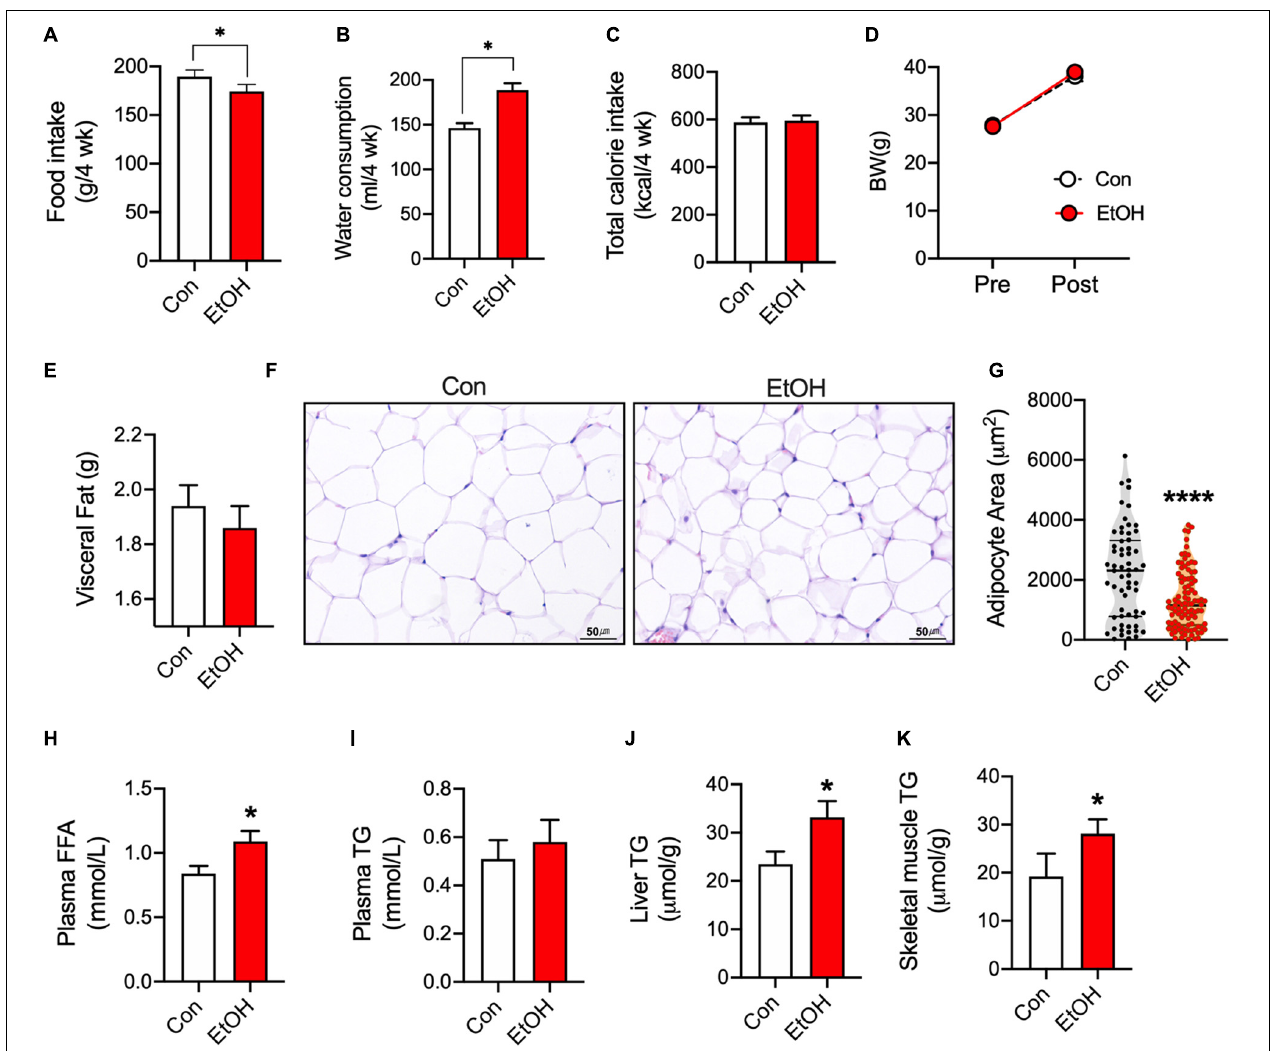
FIGURE 1 | Chronic alcohol consumption released fatty acids from adipose tissue and increased triglyceride accumulation in mouse skeletal muscle. (A) Food intake ( n = 6 mice), (B) Water consumption ( n = 6 mice), and (C) Total calorie intake ( n = 6). Values are means ± SE. * P < 0.05. Significance was determined using the student’s t -test. (D) 5% EtOH consumption did not affect body weights ( n = 6 animal/group). (E) Visceral fat weights ( n = 6 tissue/group). (F) Sections of epididymal white adipose tissue from mice after treatment with water or 5% EtOH. (G) Adipocyte area was quantified from section of adipose tissue. Values are means ± SE. **** P < 0.0001. Significance was determined using the student’s t -test. (H) EtOH consumption increased plasma free fatty acid levels (FFA) ( n = 6 plasma/group). Values are means ± SE. * P < 0.05. Significance was determined using the student’s t -test. (I) Plasma triglyceride (TG) level ( n = 6 plasma samples/group). (J , K) EtOH consumption increased liver and skeletal muscle TG levels ( n = 6 tissue samples/group). Values are means ± SE. * P < 0.05 versus non-treated controls. Significance was determined using student’s t -test. (G) H&E staining was used to determine adipocyte sizes at different EtOH